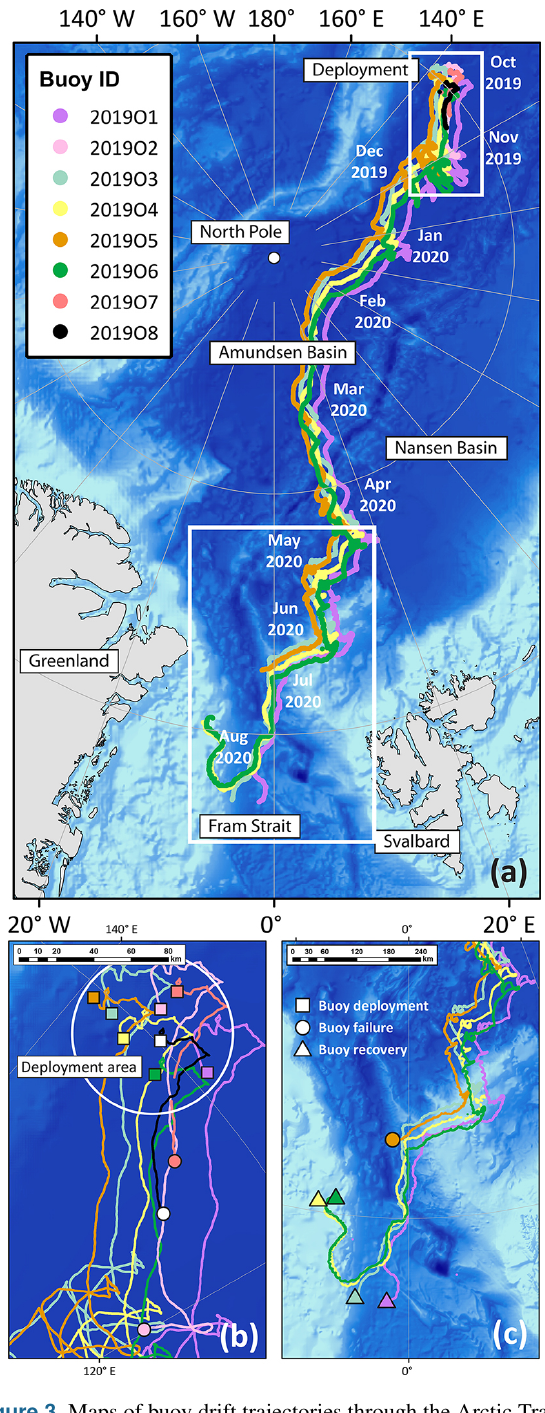
Figure 3. Maps of buoy drift trajectories through the Arctic Trans- polar Drift between October 2019 and August 2020. (a) Overview map. (b) Initial setup north of the Laptev Sea and the first weeks of the drift. (c) The last weeks of the drift in Fram Strait. Squares indi- cate deployment locations, and circles indicate locations of failure or recovery. Bathymetric data were obtained from the International Bathymetric Chart of the Arctic Ocean (IBCAO) project (Jakobs- son et al., 2020). Coastline data are taken from Wessel and Smith